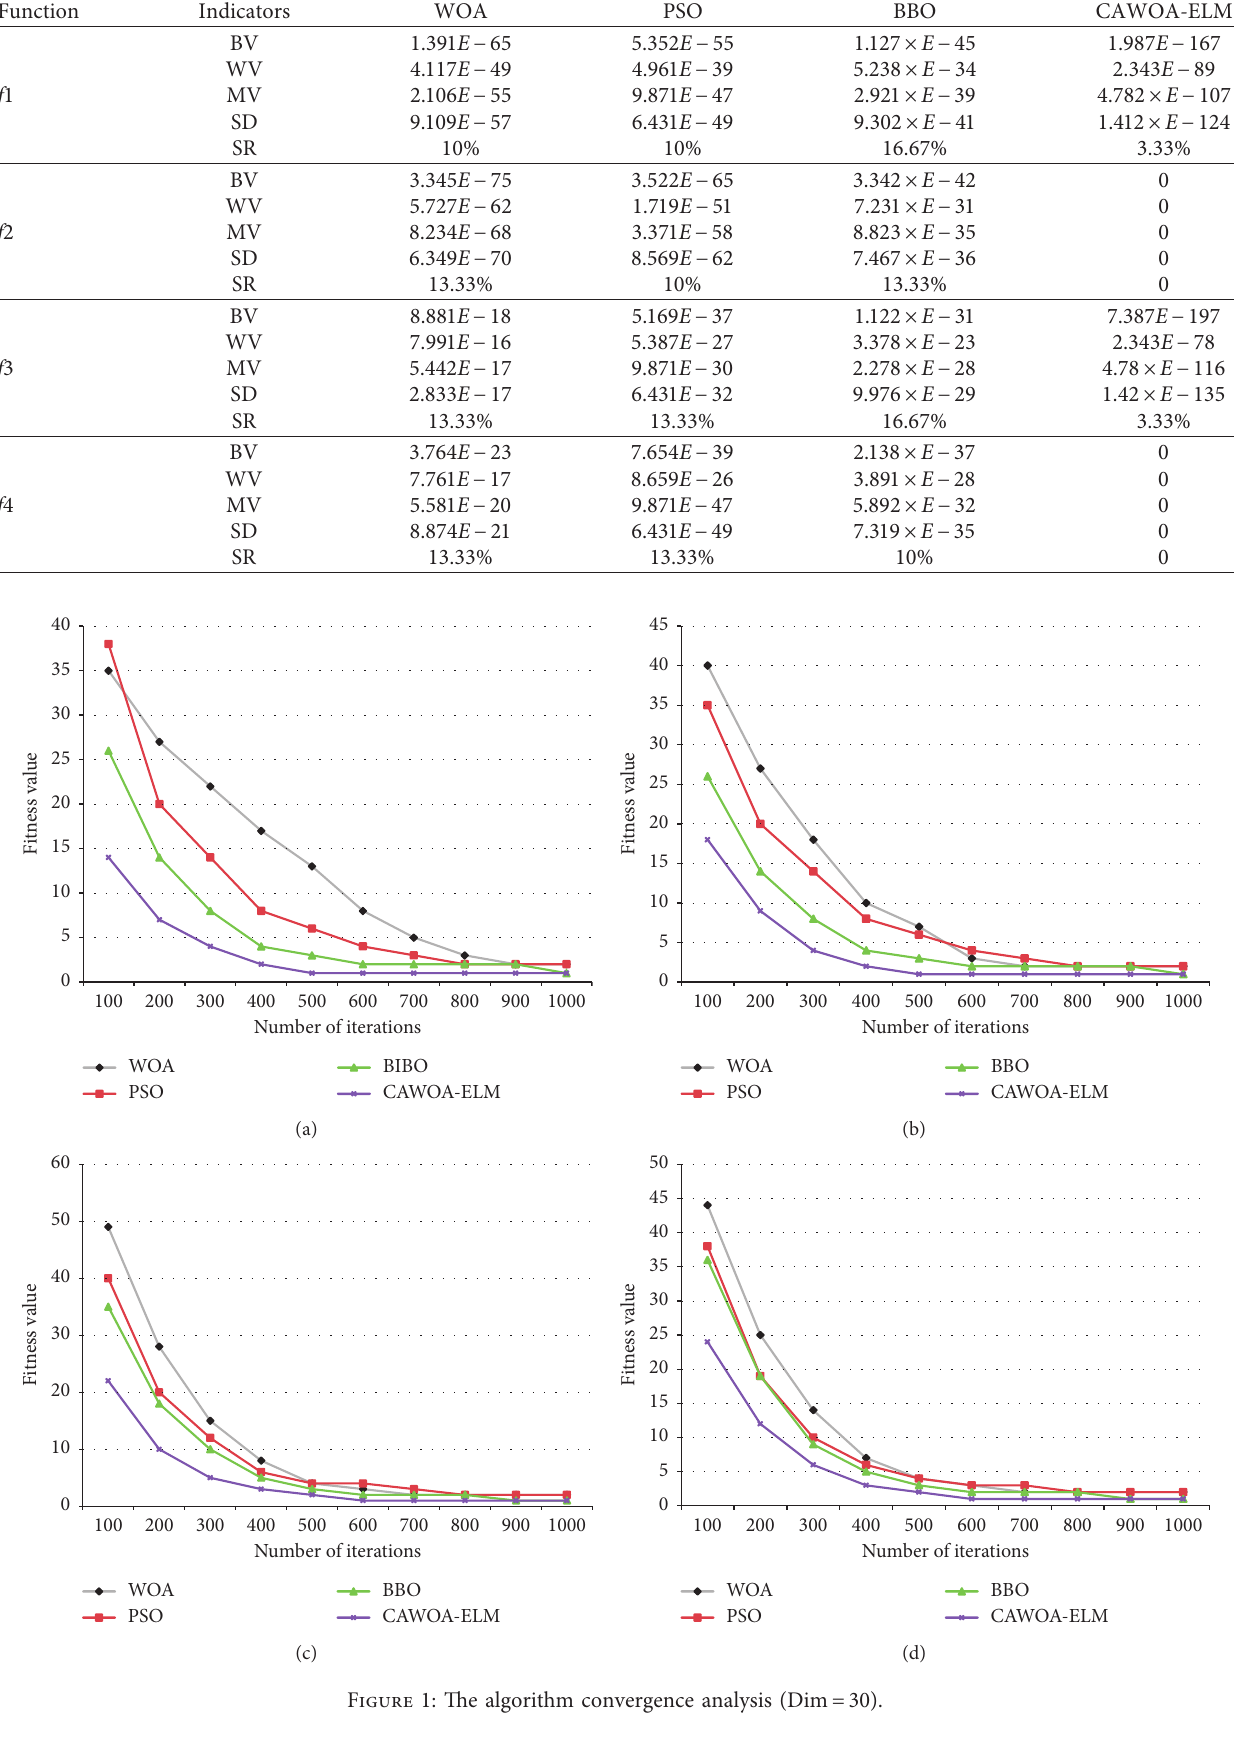
Table 1: Simulation results.